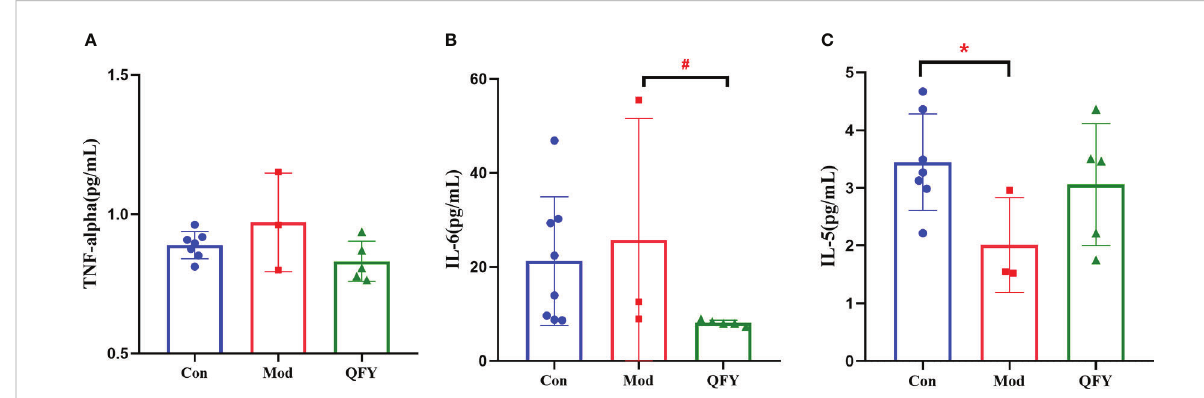
FIGURE 11 Effects of Qi-Fu-Yin on the level of cytokines in plasma of APP/PS1 transgenic mice. (A) TNF- a , (B) IL-6, (C) IL-5; Mean ± SD, n=3~8, *# P <0.05, unpaired Student`s t -test, Graphad Prism8.0.1